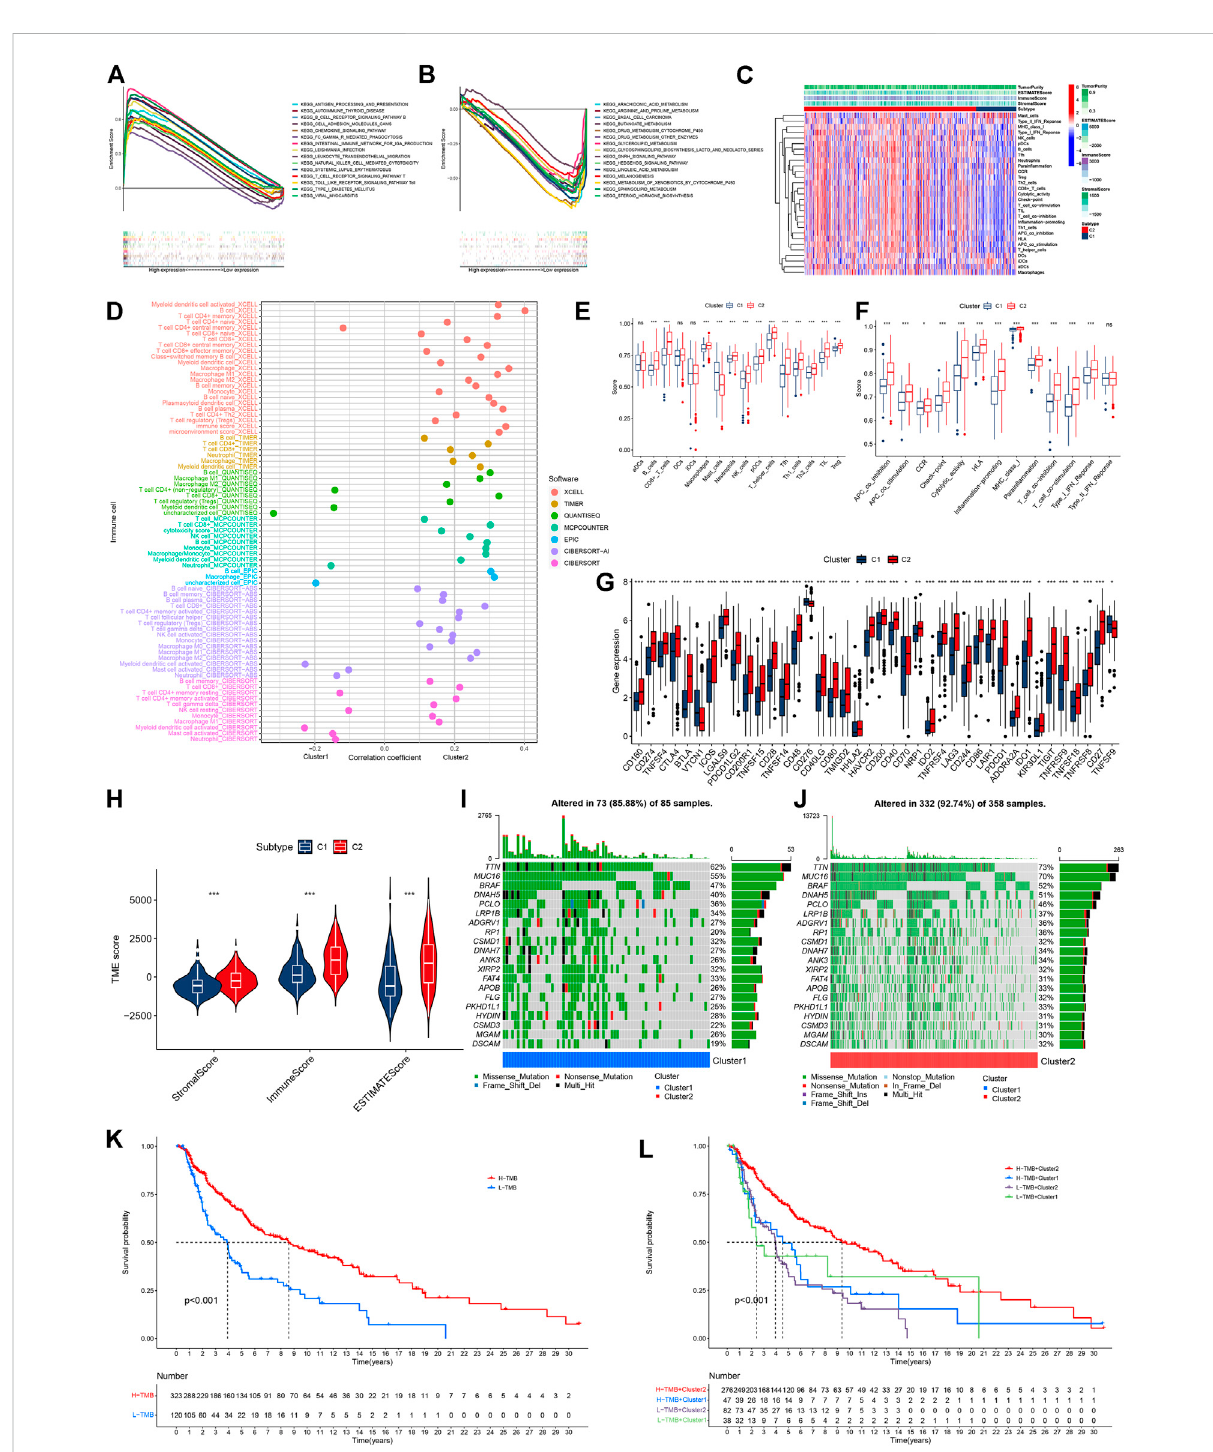
FIGURE 3 Analyses of tumor immune characteristics and TMB in these two clusters of CM cases. (A) Multi-GSEA analyses of cluster 2 CM cases. (B) multi- GSEA analyses of cluster 1 CM cases. (C) Heatmap of immune in fi ltrates between two clusters of CM cases. (D) Correlation coef fi cient of immune in fi ltrates in two clusters of CM cases. (E,F) Single-sample GSEA scores of immune cells and immune functions in two clusters of CM cases. (G) Comparisons of genes for expression of 40 checkpoints between two clusters of CM cases. (H) Comparisons of immune-related scores in two clustersofCM cases. (I,J) WaterfallplotofTMB ofindividual patients incluster1and cluster2. (K) Kaplan – MeieranalysisofOS between thelow- and high-TMB groups of CM cases. (L) Kaplan – Meier analysis of OS among four groups of CM cases. * p < 0.05, ** p < 0.01, and *** p < 0.001. A p value of < 0.05 was considered to indicate a statistically signi fi cant